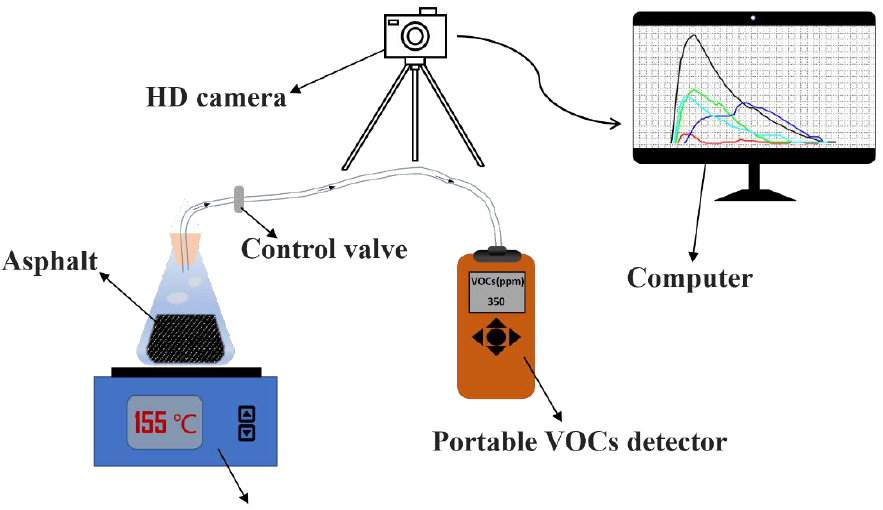
Figure 3. Asphalt heating-emission collection and detection device.